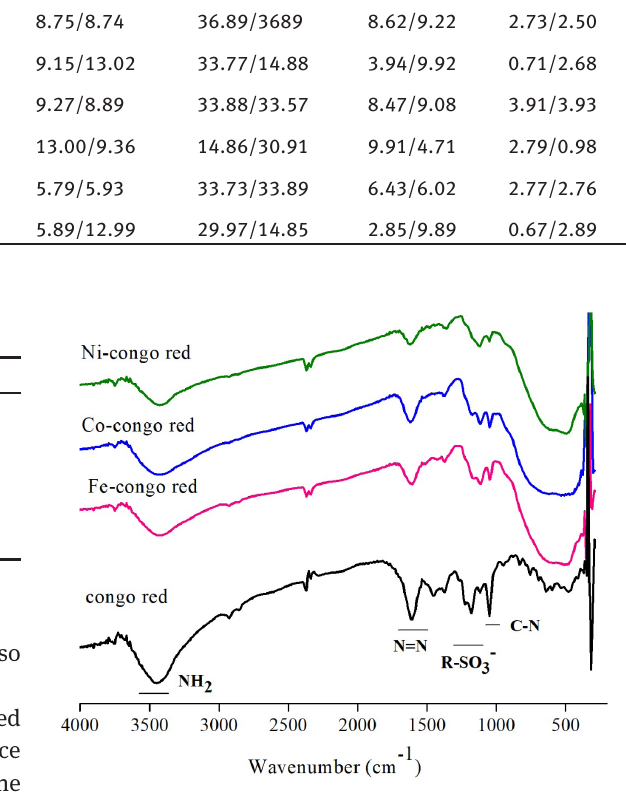
Figure 3: The determination of functional groups of congo red complexes using